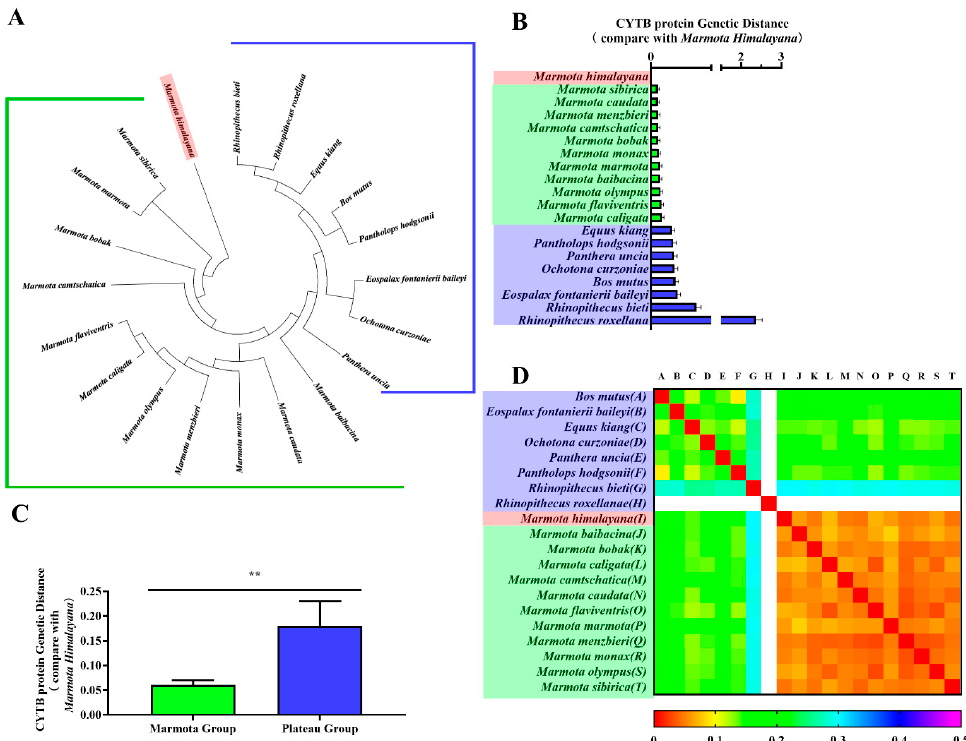
Figure 3. Phylogenetic analyses of CYTB protein. Phylogenetic trees for the CYTB protein were constructed in MEGA ( A ). The genetic distance from the Himalayan marmot to each member of the marmot group and the plateau group are represented as a bar chart ( B ). One-way ANOVA showed a significant difference (** p < 0.01) between the groups ( C ). A heatmap represents the correlation coefficients of the CYTB protein genetic distance for all species ( D ).